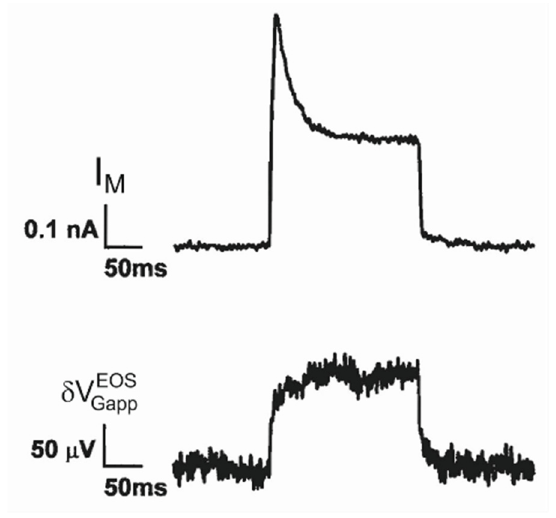
Figure 8. Transistor recording of potassium conductances in cultured hippocampal rat neuron at a constant intracellular voltage [33]. ( Top ) Total membrane current; ( Bottom ) Transistor recording. After a prepolarization for 200 ms to − 110 mV , the cell was depolarized to 20 mV and repolarized to − 50 mV . The current exhibits an inactivating A-type potassium conductance and a non-inactivating K-type potassium conductance. The transistor signal is assigned to the K-type conductance with a fast current-induced response and a slow component due to the changing potassium concentration. There is no transistor response to the A-type conductance.